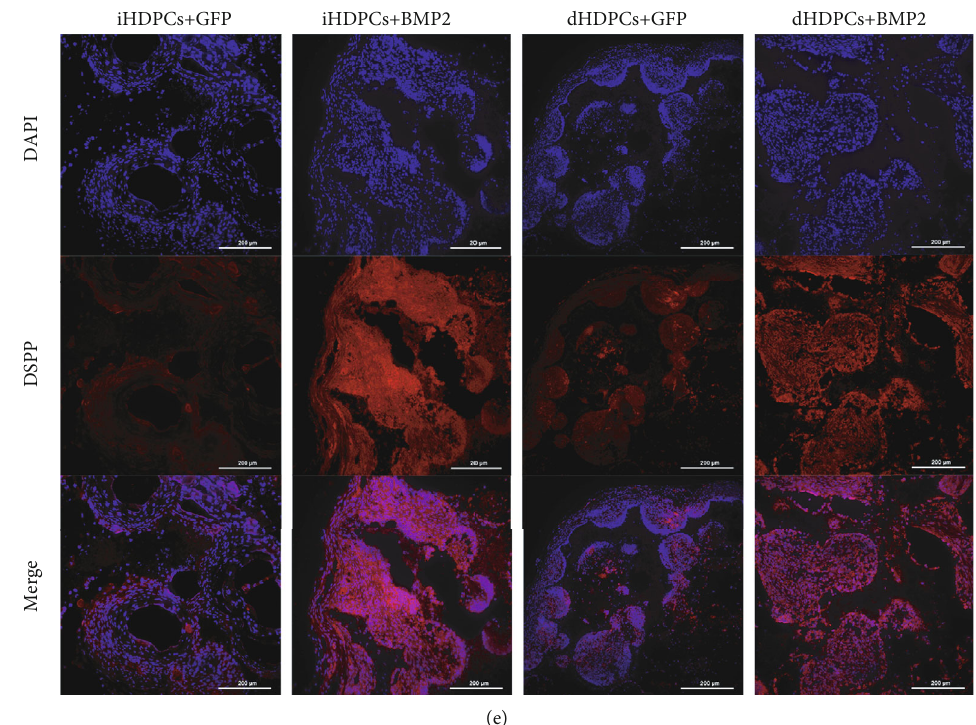
Figure 6: IHDPCs can di ff erentiate into odontoblasts when combined with a beta-tricalcium phosphate sca ff old and growth factor in vivo . (a) BMP2 promotes the di ff erentiation and mineralization of iHDPCs and dHDPCs in vitro . ALP staining of iHDPCs and dHDPCs after culture in odontogenic medium for 5 days. (b) Composites of sca ff olds and cells were carefully implanted into the dorsal subcutaneous region of nude mice for 4 weeks. (c) H&E staining of the composites of β -TCP sca ff olds and iHDPCs/dHDPCs treated with BMP2 after subcutaneous implantation for 4 weeks. (d) Masson ’ s trichrome staining of the composites. (e) The levels of DSPP in the β -TCP sca ff old and iHDPC/dHDPC composites were analyzed by immunocytochemical